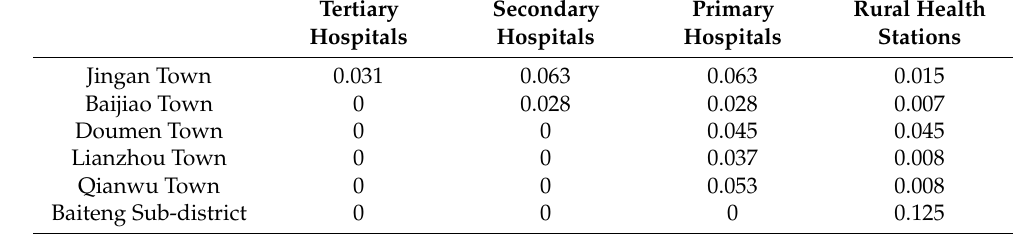
Figure 4. Zoning map of the service scope of multilevel public health facilities in Doumen District, of Zhuhai (Guangdong Province), China, 2020. ( a ) Service scope of the tertiary hospitals. ( b ) Service scope of the secondary hospitals. ( c ) Service scope of the primary hospitals. ( d ) Service scope of the rural health stations.